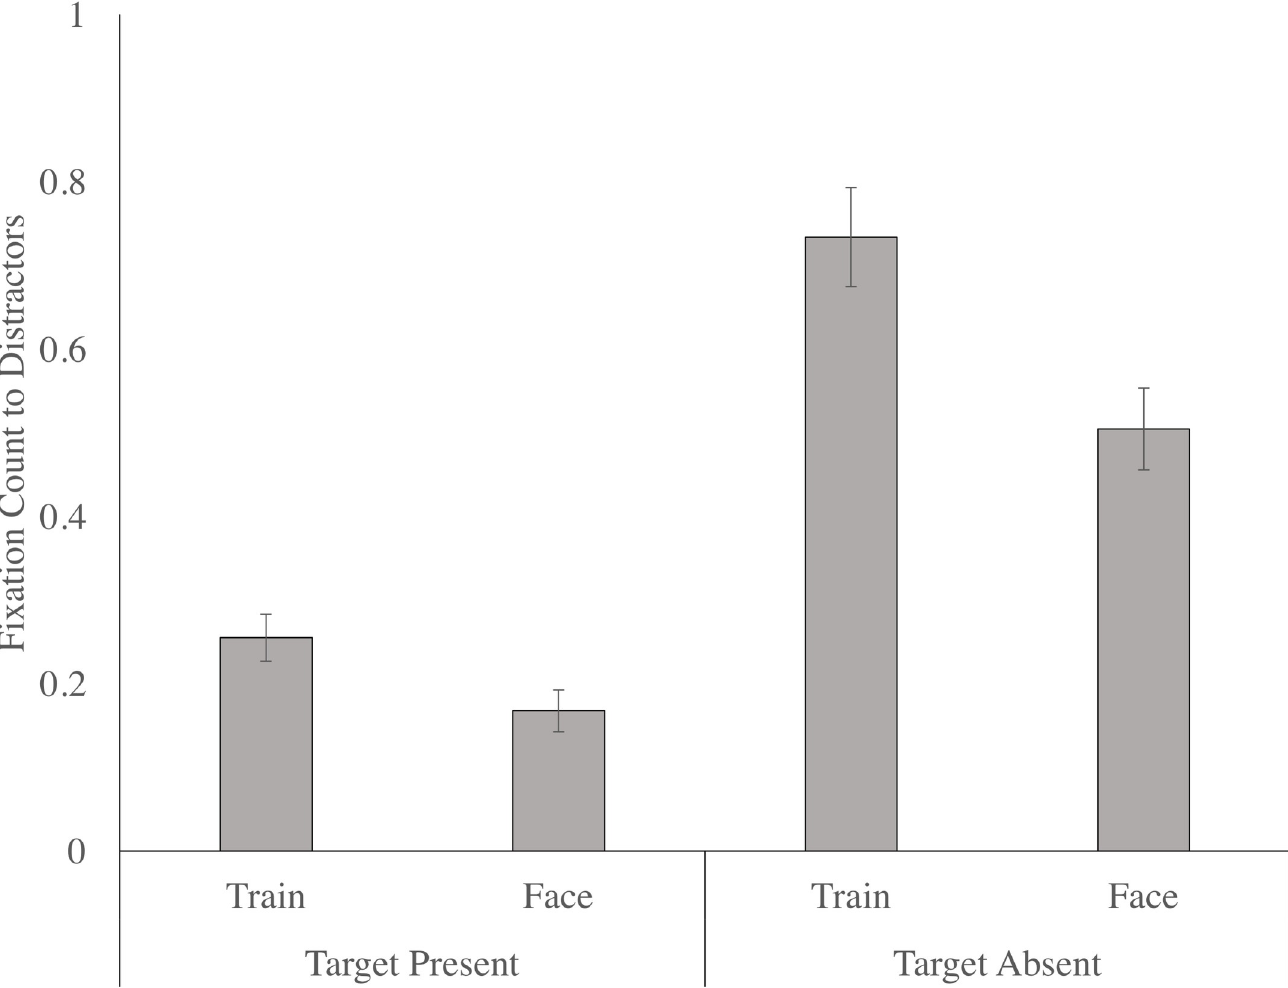
Fig 7. The number of fixations to the distractors (mean and standard error), collapsed across both autistic and non-autistic children in the upright condition as a function of target (present, absent) and distractor (train, face).